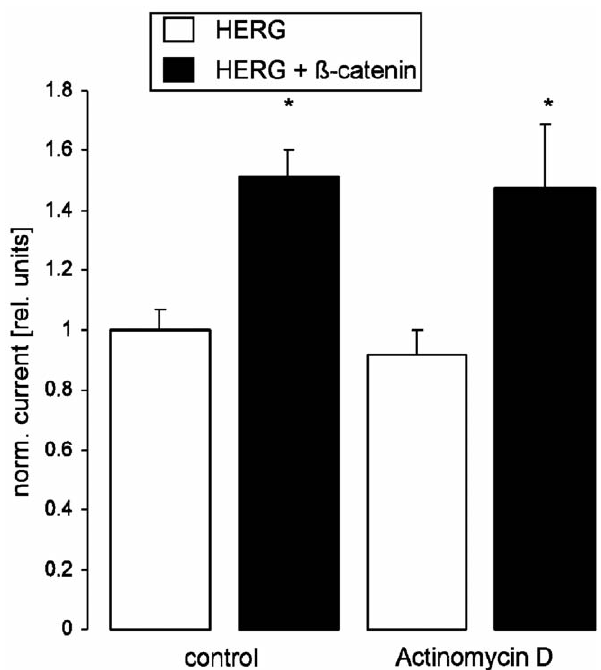
Figure 2. The effect of ß-catenin on HERG currents is not modified by actinomycin D. Arithmetic means 6 SEM (n=9–13) of the normalized outward tail current following a depolarization to + 80 mV recorded in oocytes injected with cRNA encoding HERG (white bars) or with RNA encoding HERG and ß-catenin (black bars), incubated for 24 hours without (left bars) or with (right bars) 10 m M actinomycin D prior to the measurement. *indicates statistical significance (p , 0.05) from the absence of ß-catenin cRNA.